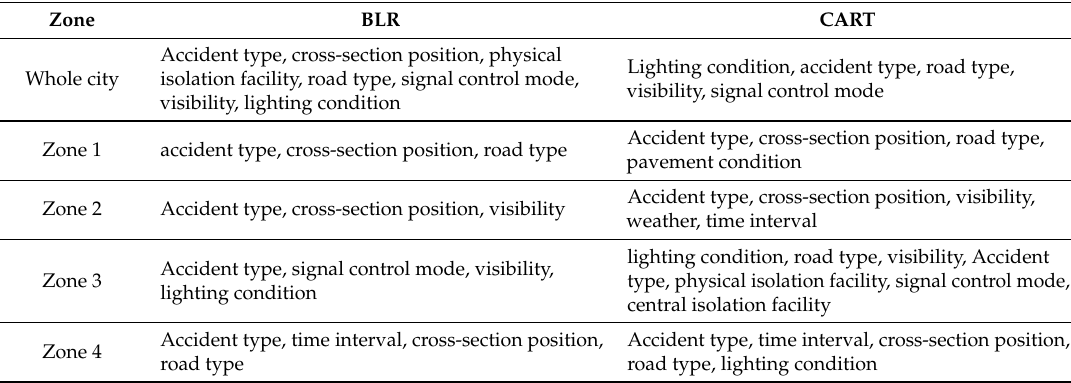
Table 8. Consistence analysis of BLR and CART.